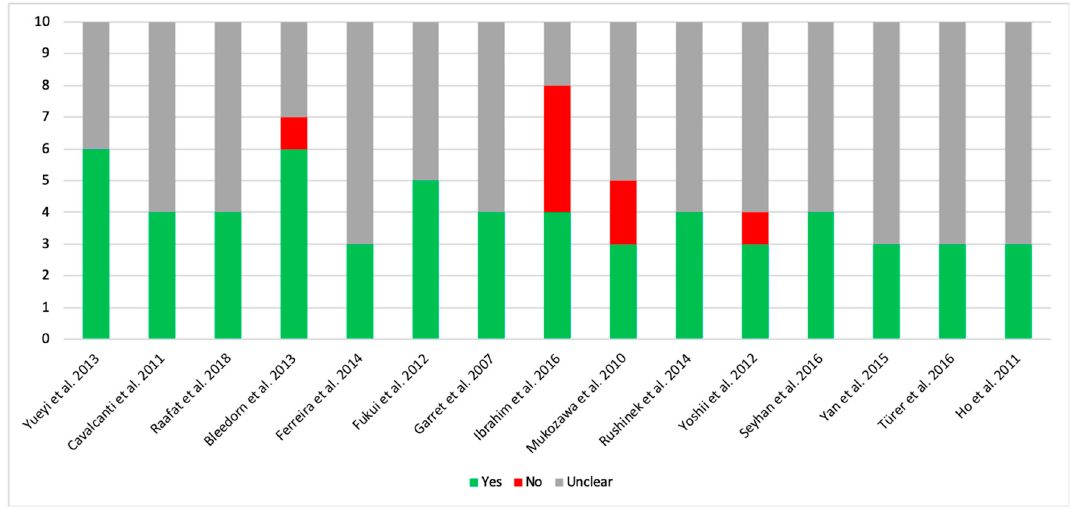
Figure 3. Risk of bias measured with the SYRCLE’s tool.